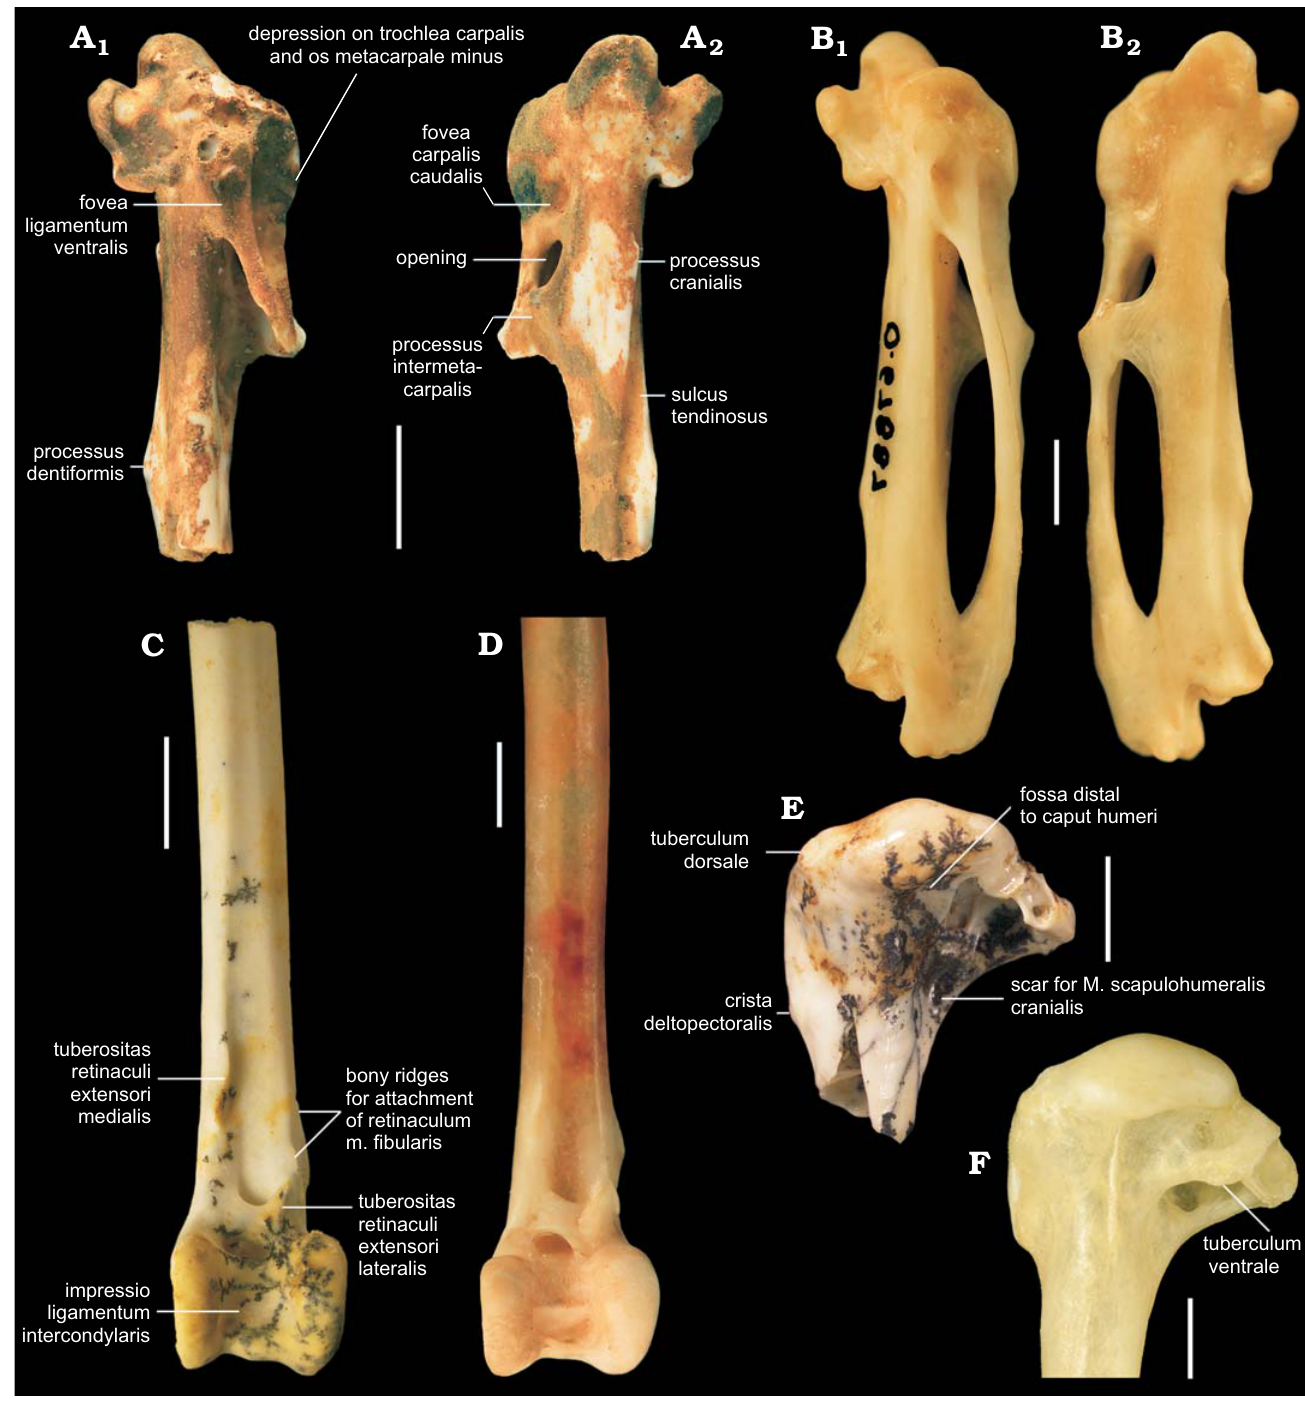
Fig. 1. Quail-thrush bird Cinclosoma elachum sp. nov. (A, C, E) from the Riversleigh World Heritage Area, Australia, compared with the Recent Cin- closoma punctatum (Shaw, 1794) (B, D, F) . A . QM F57949 (holotype), early Miocene Wayne’s Wok Site, right carpometacarpus in ventral (A 1 ) and